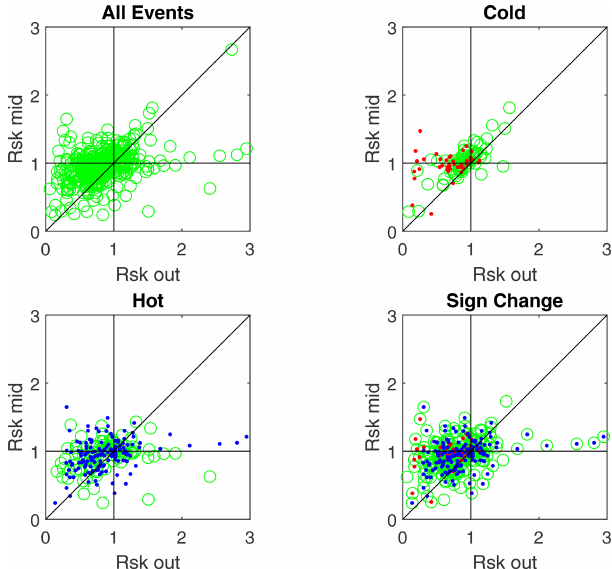
Figure 15. The MM instability criterion of Eq. (1), R SK , inside the LMH vs. outside. The full list of structures and the three cat- egories are shown. The horizontal and vertical black lines show where R SK = 1, and the diagonal black line is the identity. The red (43) and blue (155) dots are the cold and hot LMHs in the sign change category.